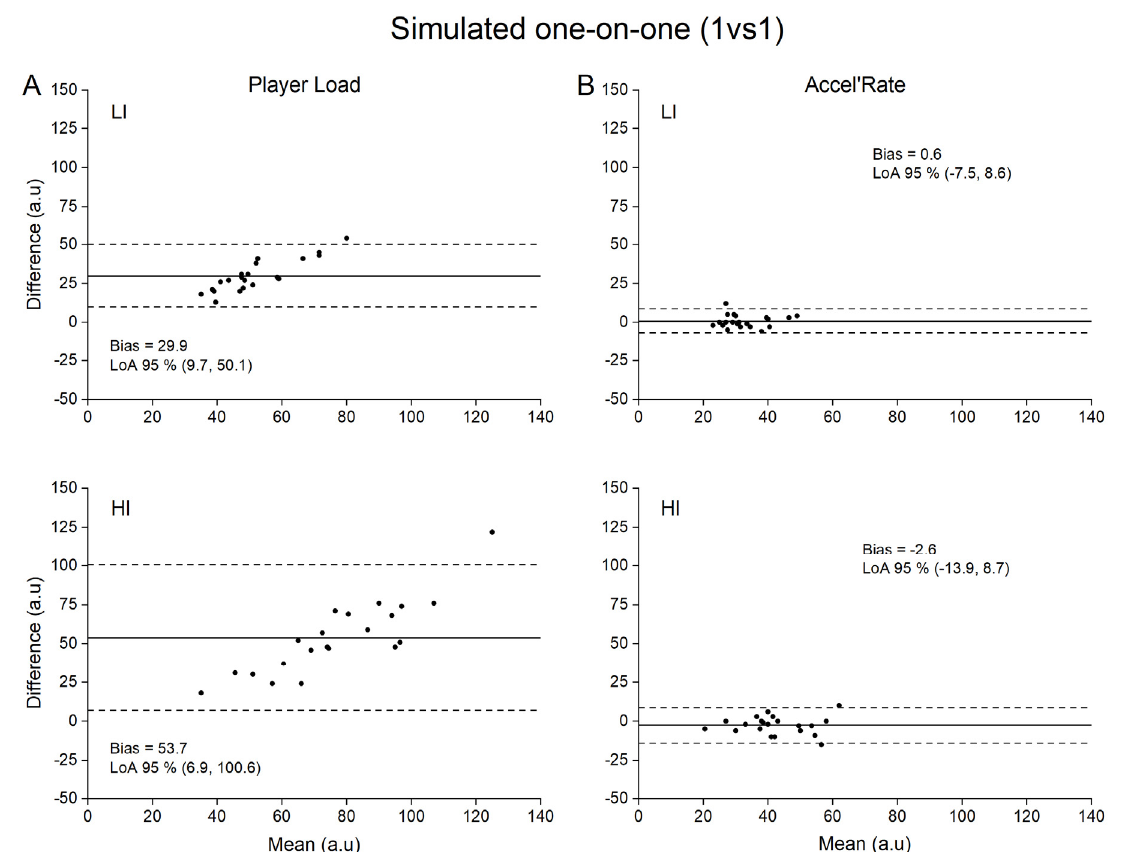
Figure 5. Bland-Altman plots of difference between criterion and practical measurements for simulated one-on-one (1 vs. 1). For the sake of clarity, only data obtained for the upper back position are depicted. ( A ): Player Load measured by accelerometer (practical) versus by force plates (criterion) at low (LI) and high (HI) intensity; ( B ): Accel’Rate measured by accelerometer (practical) versus by force plates (criterion) at low (LI) and high (HI) intensity. Solid lines depict mean bias and dashed lines depict 95% limits of agreement (LoA).